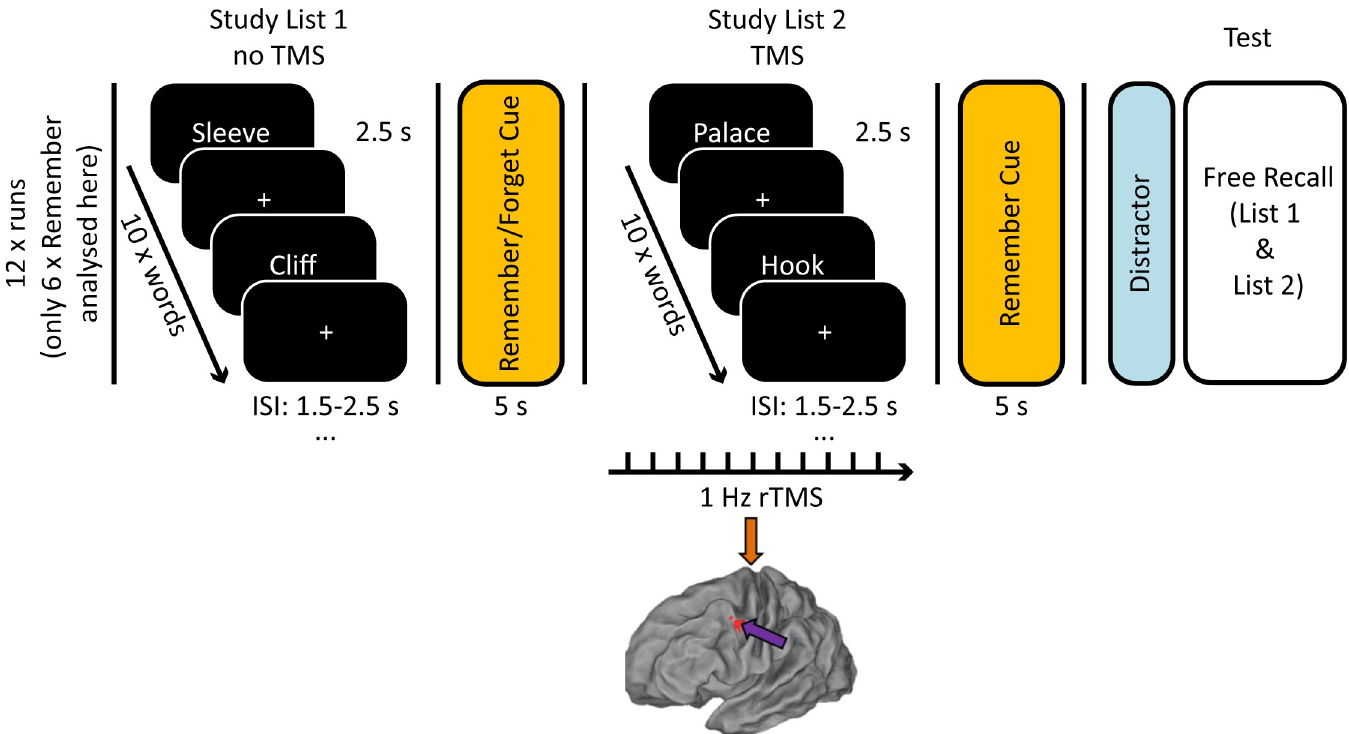
Fig 1. Experimental design. Arrows on brain model indicate stimulation site (DLPFC = purple, vertex = orange). Participants were asked to study 2 lists of 10 words over 12 runs. During encoding of List 2, 45 pulses of 1 Hz rTMS were applied to the left DLPFC (MNI coordinates: − 45, 6, 39) or vertex. Memory performance was assessed as percentage of correctly recalled words per list. The data and scripts used to generate this figure can be found at https://osf.io/dyxjv/. DLPFC AU : AbbreviationlistshavebeencompiledforthoseusedinFigs 1 (cid:0) 6 : Pleaseverifythatallentriesarecorrect : , dorsolateral prefrontal cortex; rTMS, repetitive transcranial magnetic stimulation; TMS, transcranial magnetic stimulation.